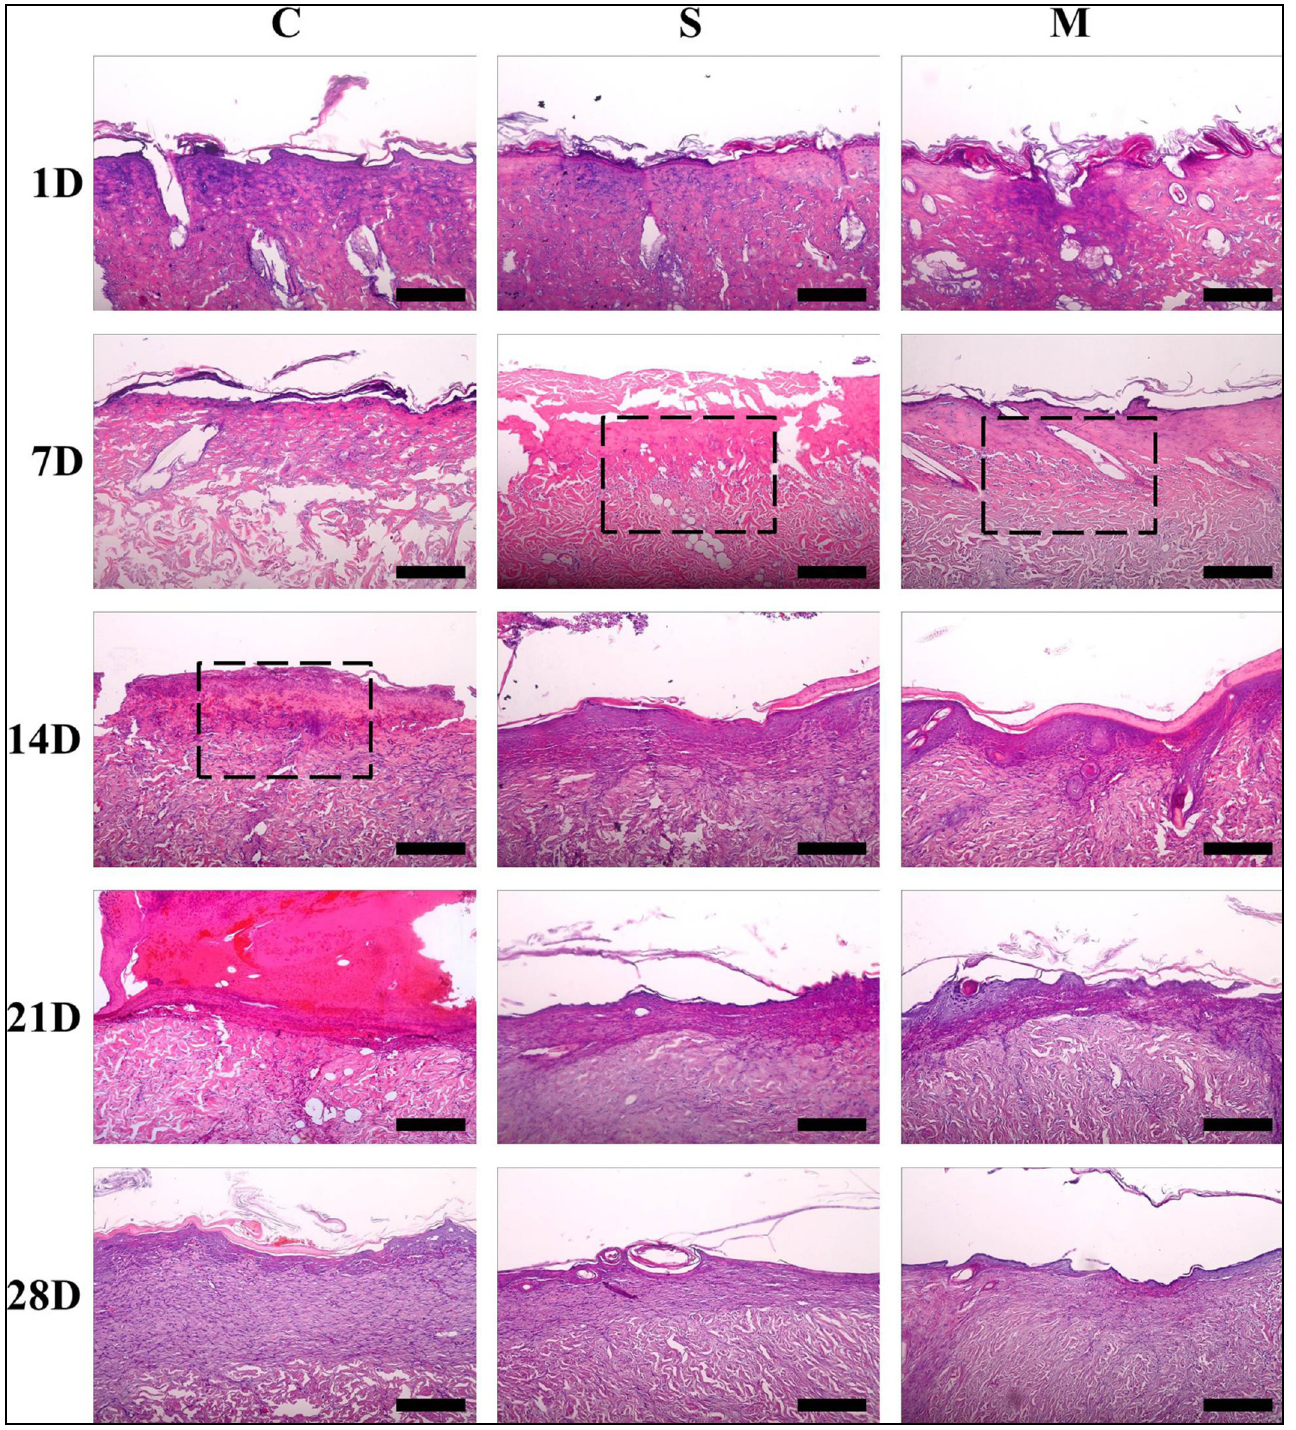
Figure 5. Burn wound tissues stained with hematoxylin and eosin (C: surgical gauze, S: SF nanomatrix, and M: Medifoam ® , scale: 100 µm). Reprinted with permission from reference [157].